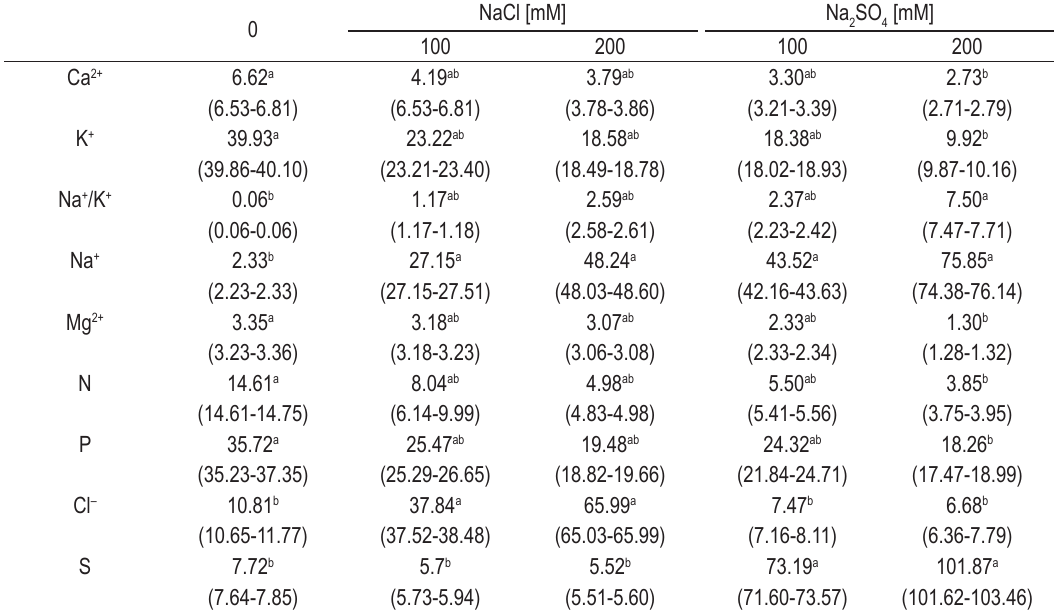
Table 1. Concentration of nutrients (mg.g –1 DW) in the tissues of Salvinia auriculata subjected to salt stress induced by NaCl and Na SO . In parentheses are the minimum and maximum values. The letters refer to statistical difference 2 4 between the control and all saline